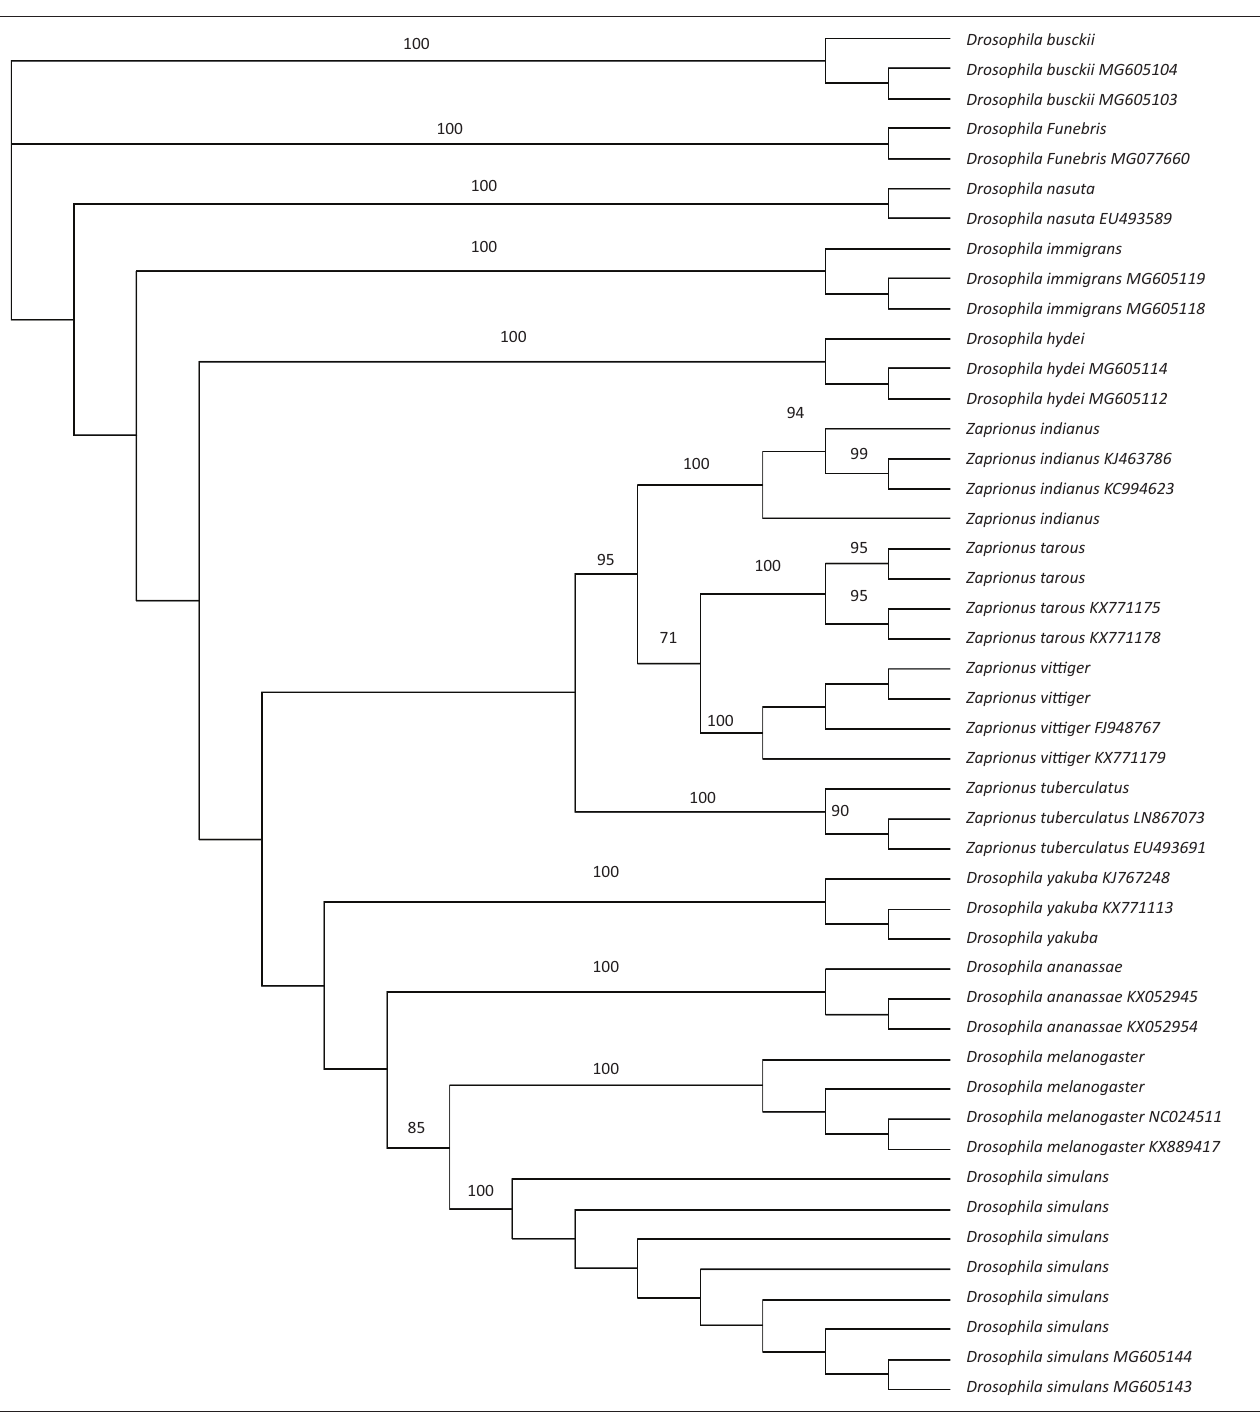
FIGURE 1: A phylogenetic tree based on maximum likelihood showing the relationships between the 13 Drosophilidae species collected in this study and reference specimens downloaded from National Center for Biotechnology Information (NCBI) (with accession numbers next to species names).The neighbour-joining tree has the same topology. Values on branches indicate bootstrap values (only values above 70 % shown) calculated over 1000